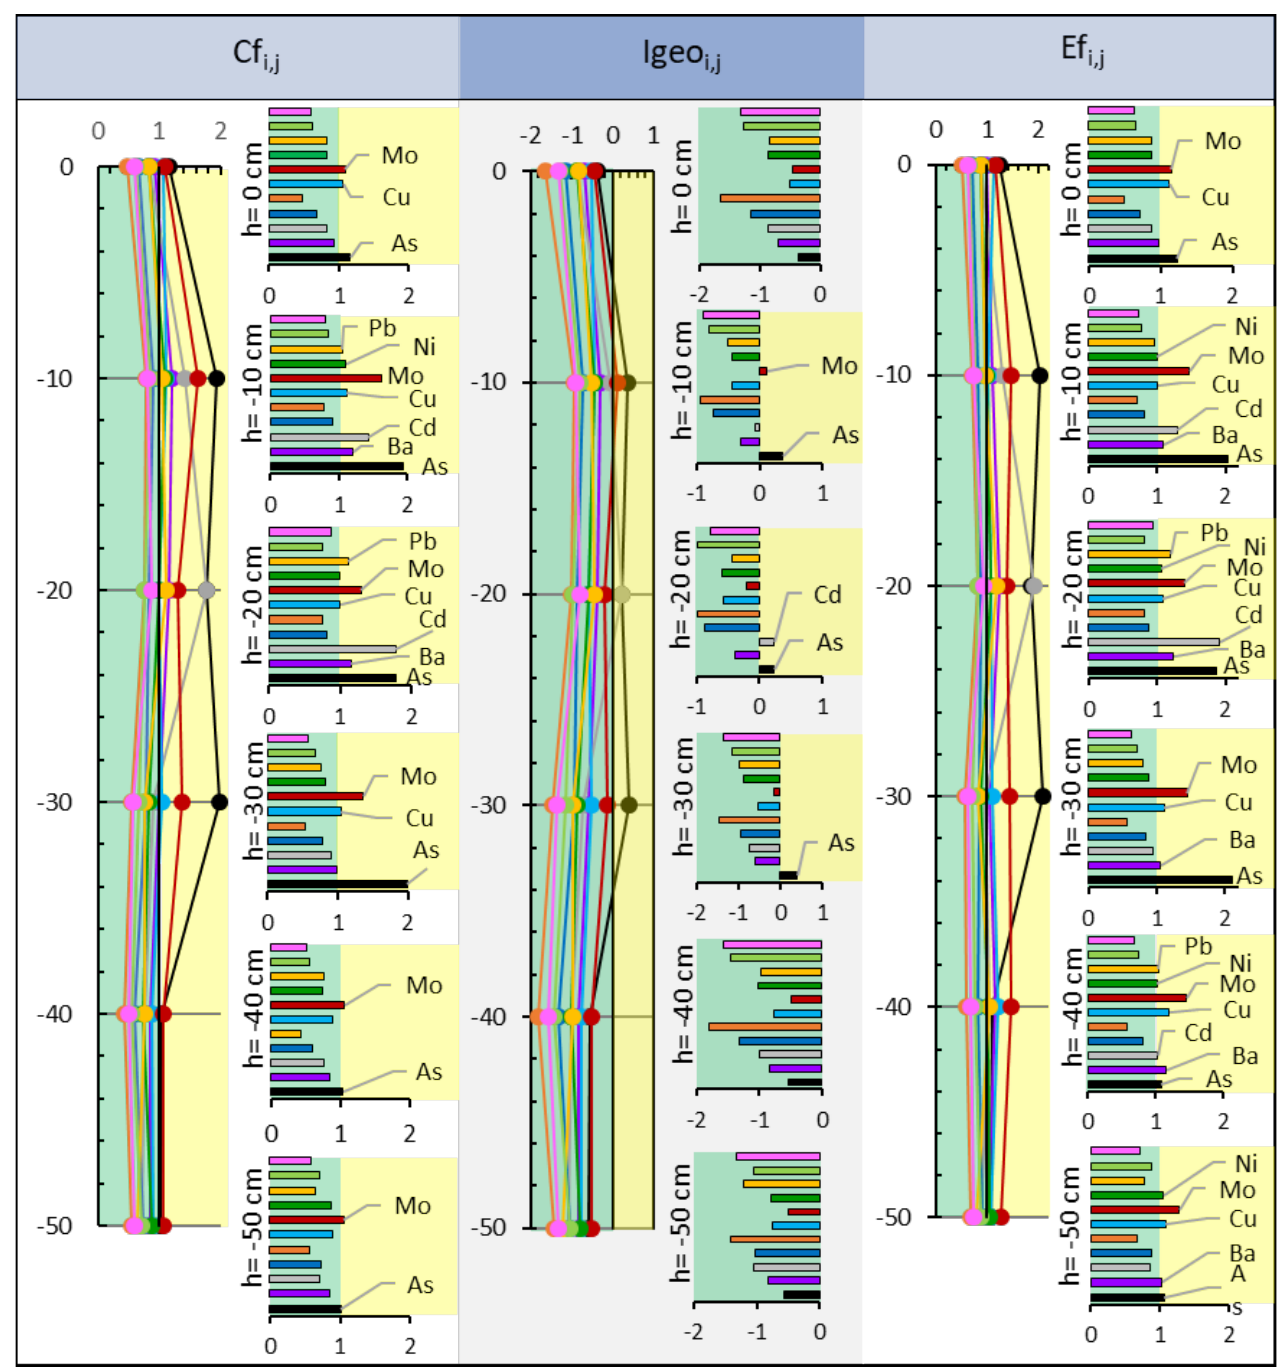
Figure 5. Profile of single contamination indices and their classification. Cf: Cf < 1 low pollu- tion, 1 < Cf < 3 moderate contamination; Igeo: Igeo < 0 uncontaminated, 0 < Igeo < 1 uncontaminated-moderately contaminated; Ef: Ef < 1 no enrichment, 1 < Ef < 3 minor en- richment. Pollutants: As, Ba, Cd, Co, Cr, Cu, Mo, Ni, Pb, V, Zn. At each depth, the bar graph is shown with the values of each element. The same color code has been used to represent the studied elements.